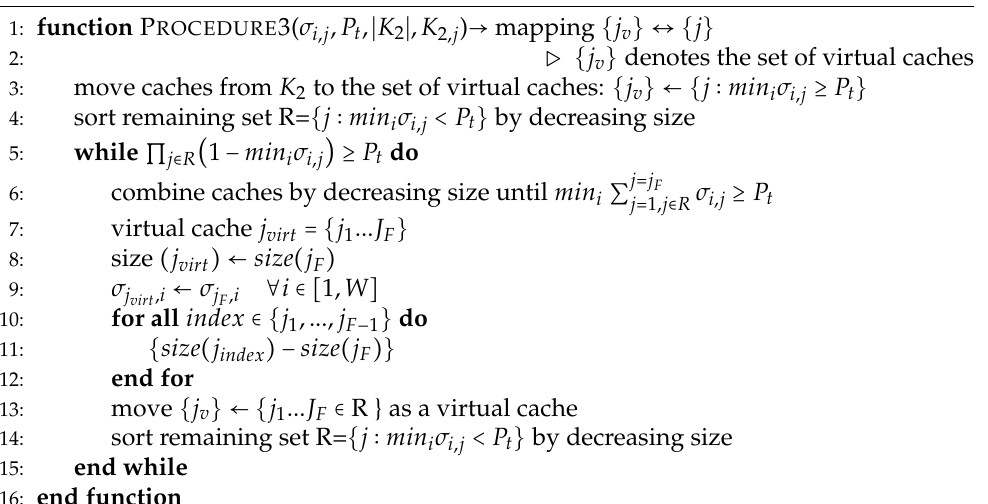
Code 6 Alternative procedure to be used in A LGORITHM 3 with virtual caches.